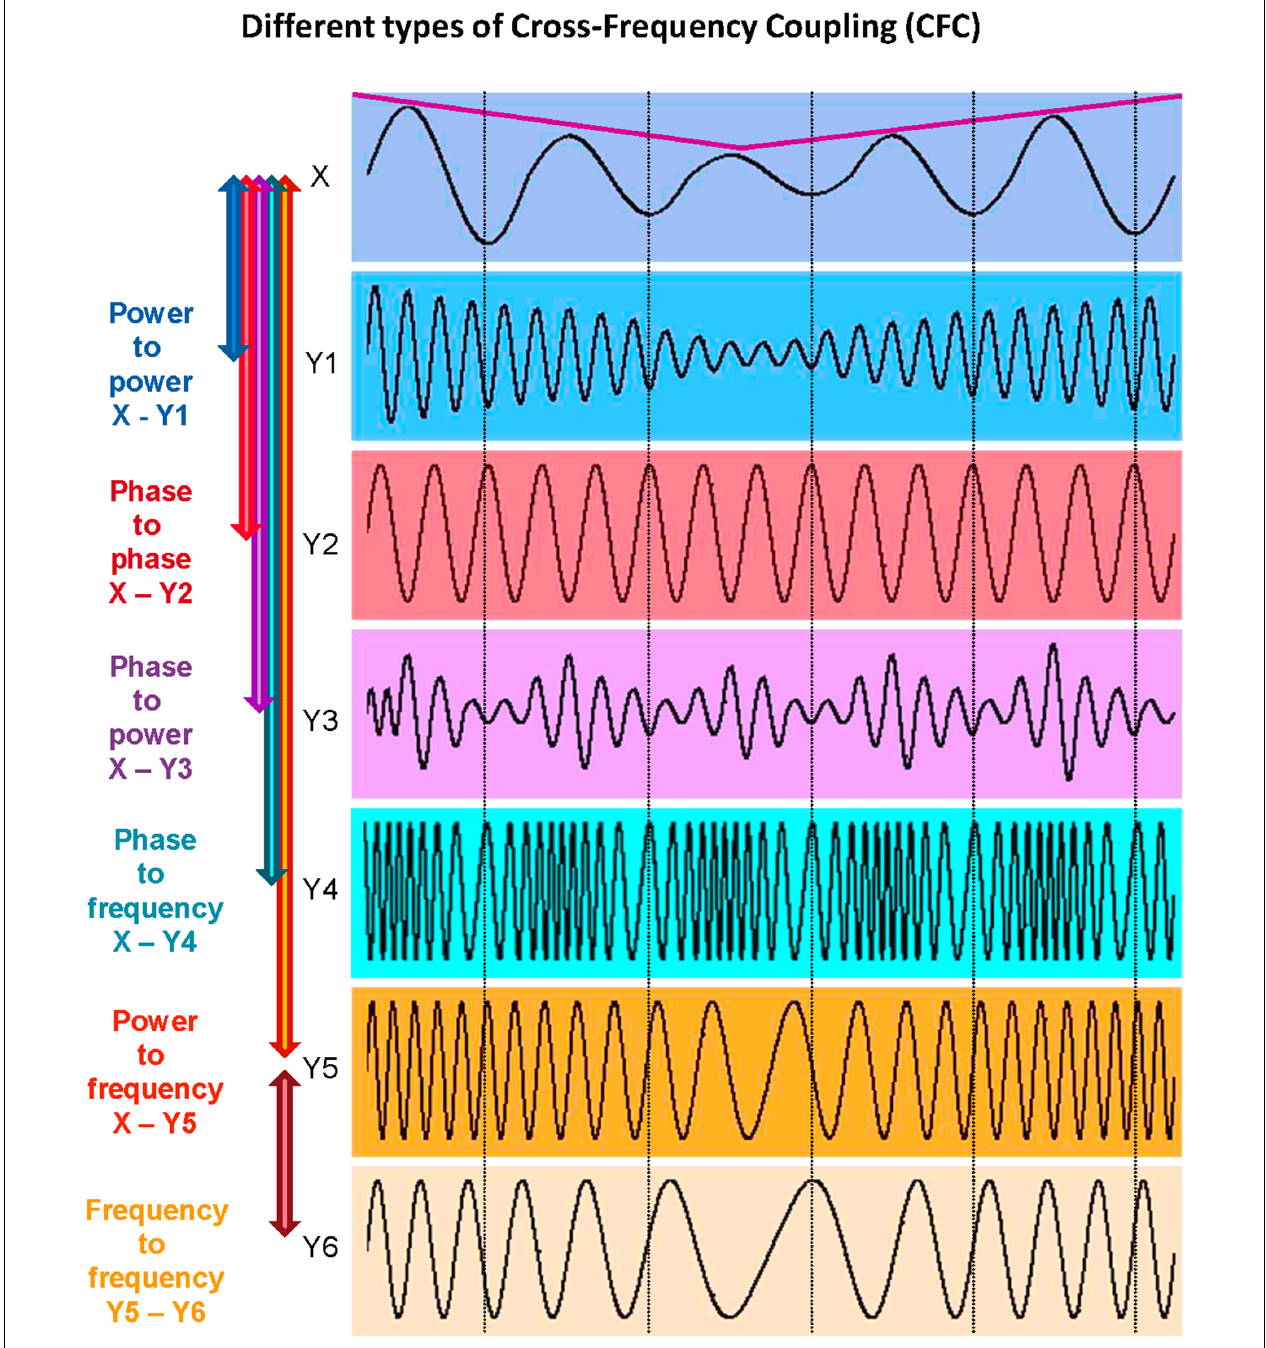
FIGURE 3 | Different types of cross-frequency coupling (CFC). Power-to-power CFC can be identified between signals X and Y1 : Signal Y1 about five times higher frequency than that of signal X shows slow amplitude modulations over time like signal X (indicated by the purple line). Phase-to-phase CFC can be identified between signals X and Y2 : Signal Y2 shows 3:1 phase-to-phase coupling with signal X , i.e., one oscillation period of signal X corresponds to three periods of signal Y2 . Phase-to-power CFC can be identified between signals X and Y3 : Signal Y3 shows fast amplitude modulations that are related (or coupled) to the phase of signal X . Phase-to-frequency CFC can be identified between signals X and Y4 : Signal Y4 shows frequency modulations that are coupled with phase changes of signal X . Power-to-frequency CFC can be identified between signals X and Y5 : Signal Y5 shows frequency modulations that are related to, or coupled with, the slow amplitude modulations of signal X (purple line). Frequency-to-frequency CFC can be identified between signals Y5 and Y6 : Signal Y6 shows slower but similar frequency modulations as the signal Y5 . The different types of CFC are not mutually exclusive (cf. Jensen and Colgin, 2007). For instance, slow amplitude modulations of signal X are coupled not only with the amplitude changes of signal Y1 but also with frequency changes of signals Y5 and Y6 , which are coupled in their frequency modulations at the same time (adapted from Jirsa and Müller, 2013).